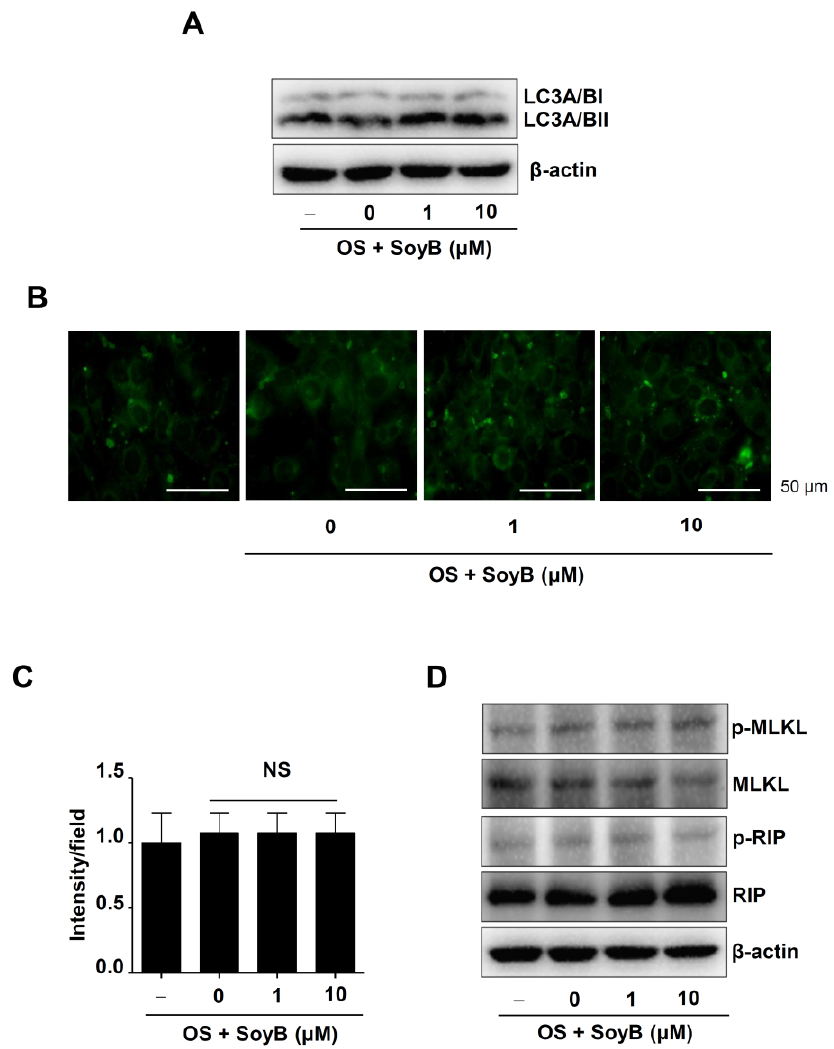
Figure 4. Osteogenic effects of SoyB on autophagic flux and necroptosis. ( A – C ) LC3A/BI and LC3A/BII levels were assessed by Western blot analysis ( A ), autophagosome formation was analyzed using DAPGreen Autophagy detection assay ( B ), and the intensity (fold) was shown as a bar graph ( C ). ( D ) Phospho-MLKL (p-MLKL), MLKL, phospho-RIP (p-RIP), RIP, and β -actin levels were assessed using Western blot analysis. Data are presented as the mean ± S.E.M. from three independent experiments. NS: not